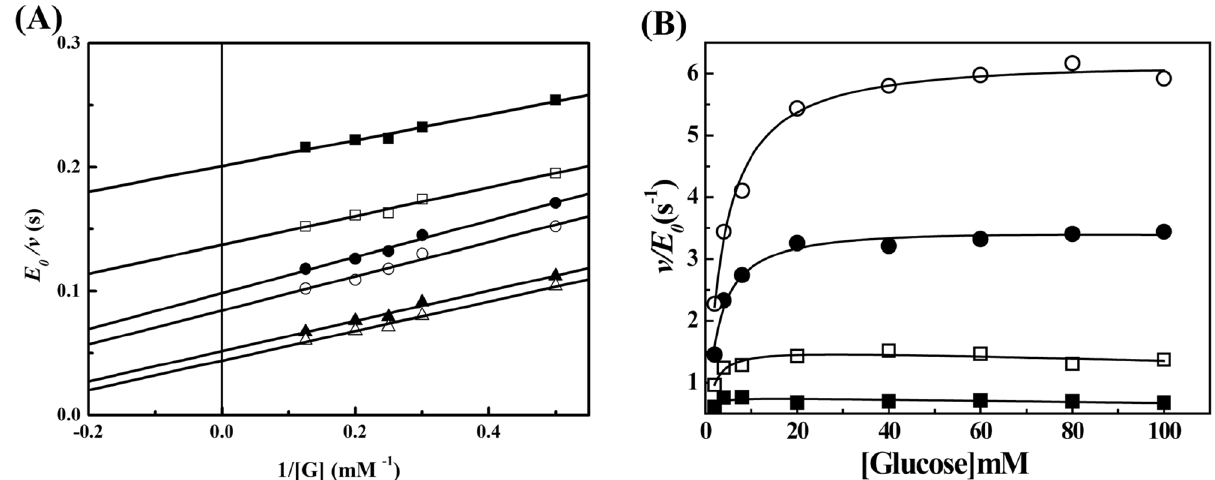
Figure 5. Kinetic mechanisms of the synthetic reaction. ( A ) Double reciprocal plots of the synthetic reaction catalyzed by Cb CBP. The concentrations of Glu-1P were as follows: 2 mM (filled square), 3 mM (open square), 4 mM (filled circle), 5 mM (open circle), 8 mM (Filled triangle) and 12 mM (open triangle). 0.98 < R 2 < 0.99. ( B ) v-[D-glucose] Plot of the synthetic reaction of Cb CBP at fixed concentrations of Glu-1P. Glu-1P was used at 1 mM (filled square), 2.5 mM (open square), 5 mM (filled circle) and 10 mM (open circle) concentrations. The theoretical lines were obtained by regressing the experimental data to the Michaelis Menten